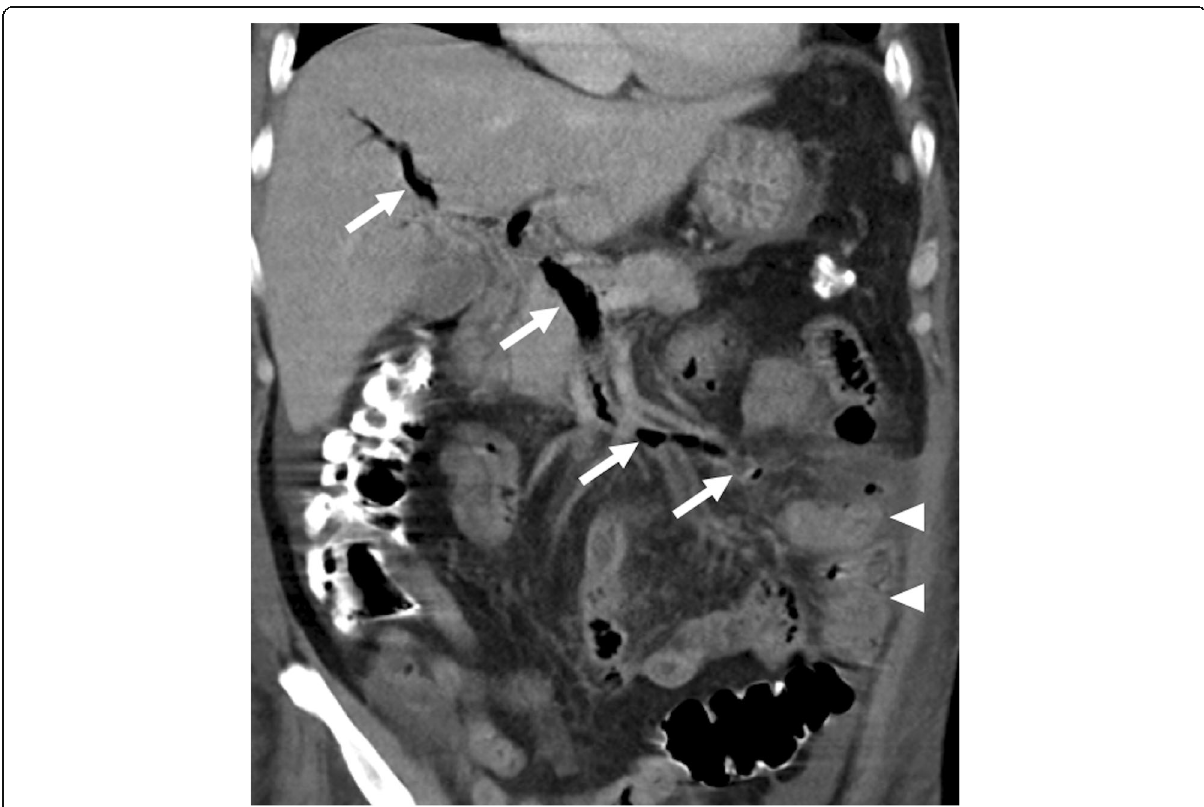
Fig. 3 Pylephlebitis. A 56-year-old man with known diabetes presented with acute onset abdominal pain and fever. Coronally reformatted post- contrast abdominal CT image demonstrated diffuse gas and thrombosis within the porto-mesenteric venous axis (arrows). Also, note is made of diffuse wall thickening (arrowheads) in the distal jejunal segment and inflammatory changes within the adjacent mesentery. Laparoscopic resection and histopathological analysis revealed acute jejunal